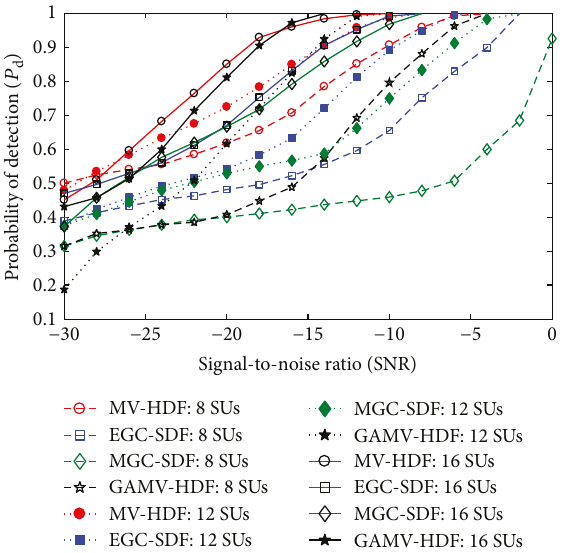
Figure 11: Probability of error versus signal-to-noise ratio at di ff erent ratios of cooperative SUs with MUs having high SNR compared with